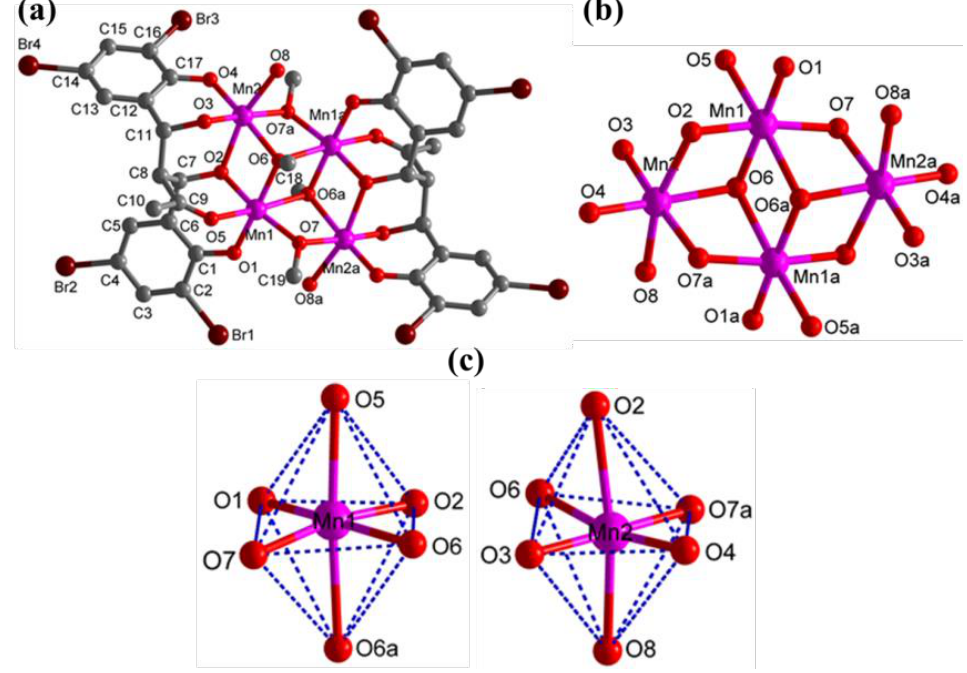
Figure 4. ( a ) Molecule structure and atom numbering of complex 3 (hydrogen atoms are omitted for clarity); ( b ) the planar Mn 4 rhombus and ( c ) the coordination polyhedra for Mn III atoms of complex 3 (symmetry code: a = 1 − x, 1 − y, 1 − z).